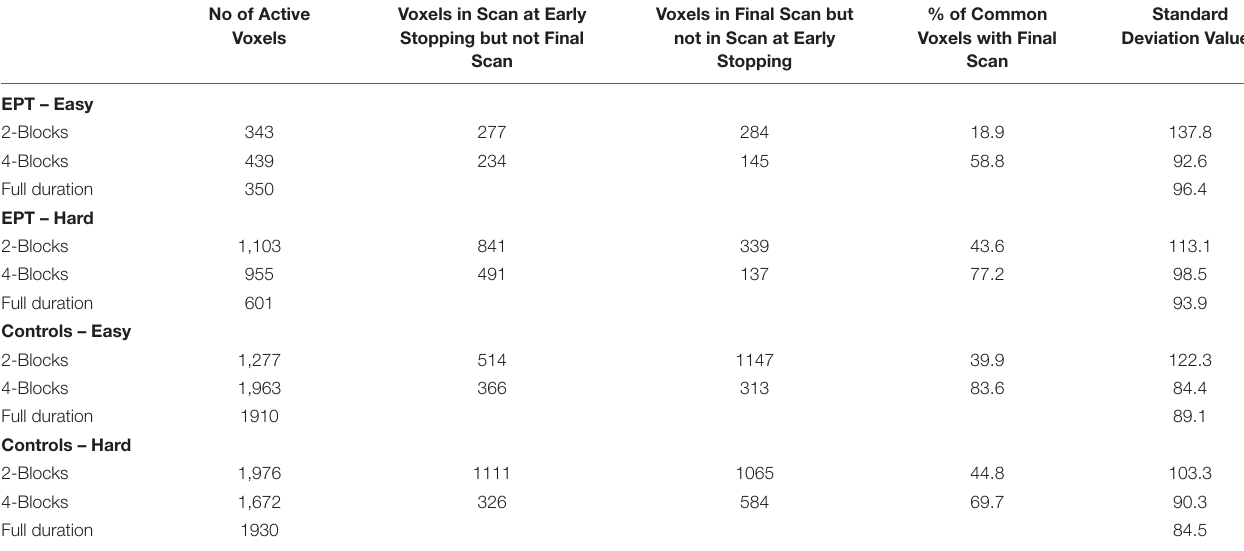
TABLE 3 | The number of active voxels that spatially overlap between early stopping and full duration group analyses are listed.